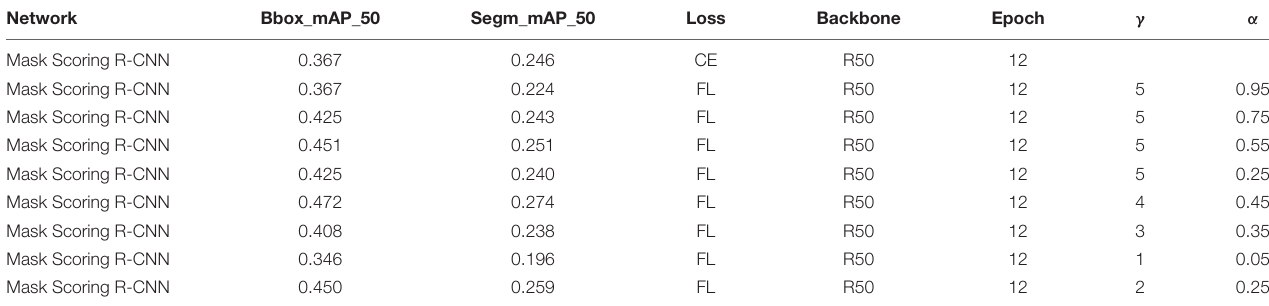
TABLE 3 | Training parameter and test results based on Mask Scoring R-CNN with different loss functions. Network